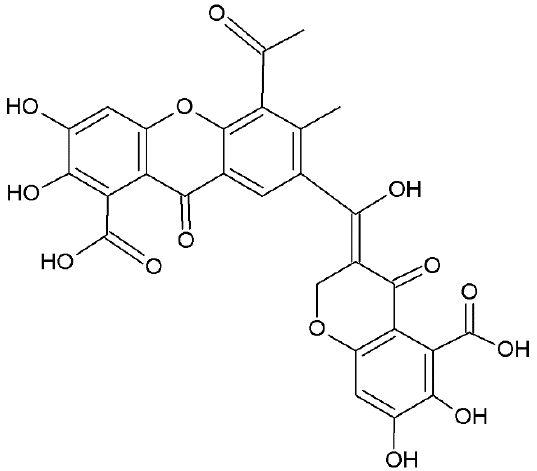
Figure 7. Structure of xanthofulvin, miscellaneous